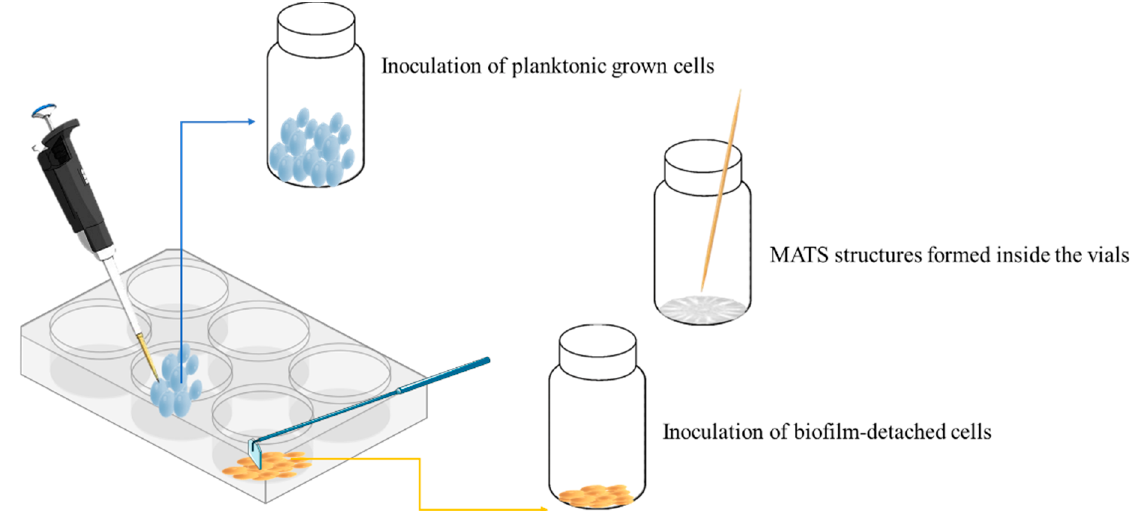
Figure 1. Obtainment of planktonic, biofilm-detached, and MATS forming-cells. Planktonic and sessile cells were obtained in 6-wells plates. Planktonic cells were removed pipetting up and down with PBS. Sessile cells were removed using a sterile cell scraper and inoculated in the vials as biofilm-detached cells. MATS were formed directly inside the vials.